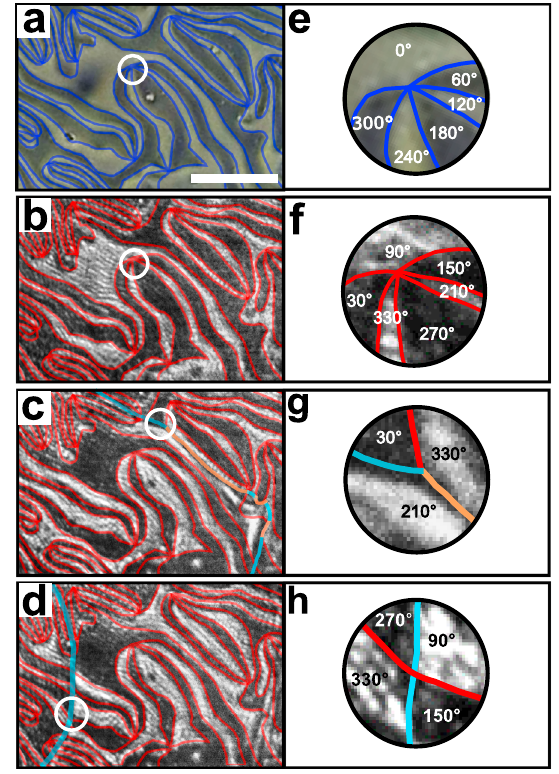
Fig. 3 Domain walls and pseudo-vortices in ErMnO 3 . a Ferroelectric ± P domain con fi guration on a c -oriented ErMnO 3 sample by phase-contrast microscopy with domain walls highlighted by blue lines. Scale bar is 25 μ